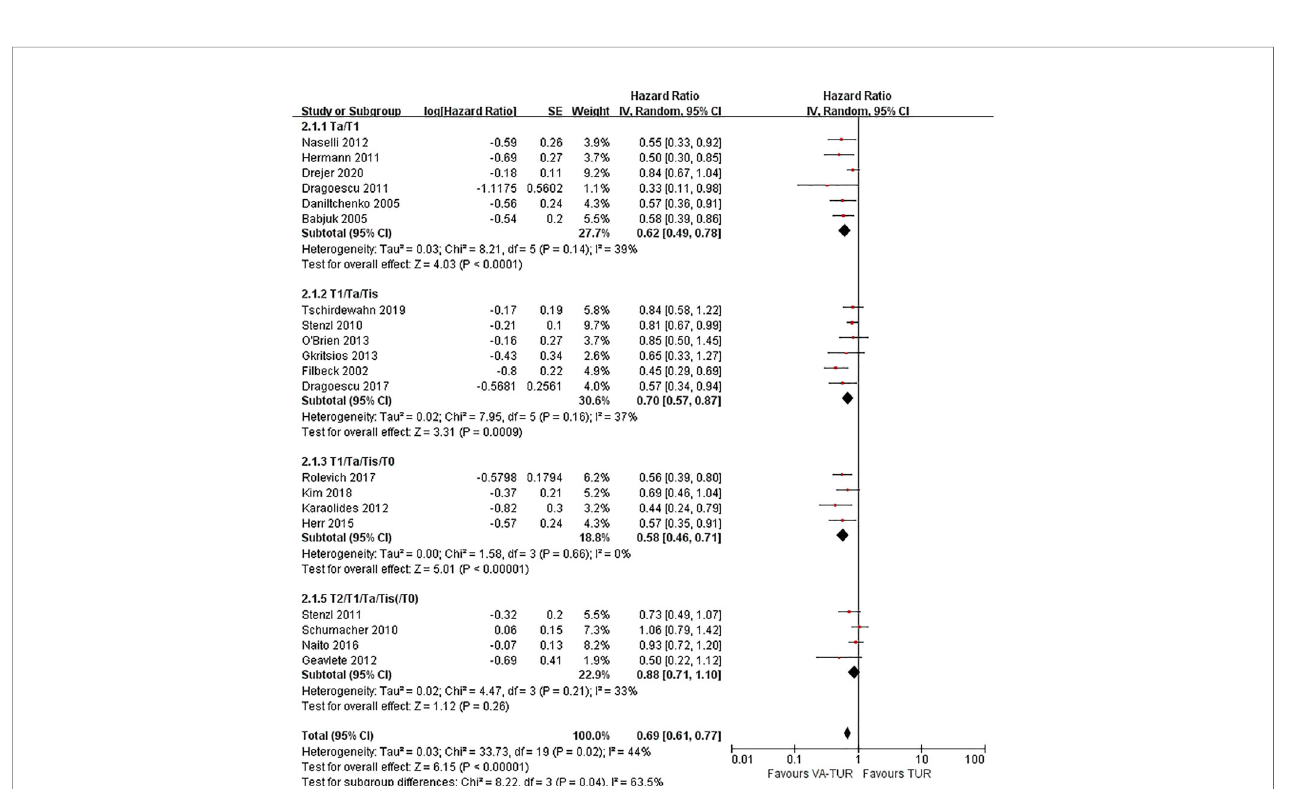
FIGURE 4 | Forest plot of RFS of VA-TUR versus TUR subgrouped by clinical stage of